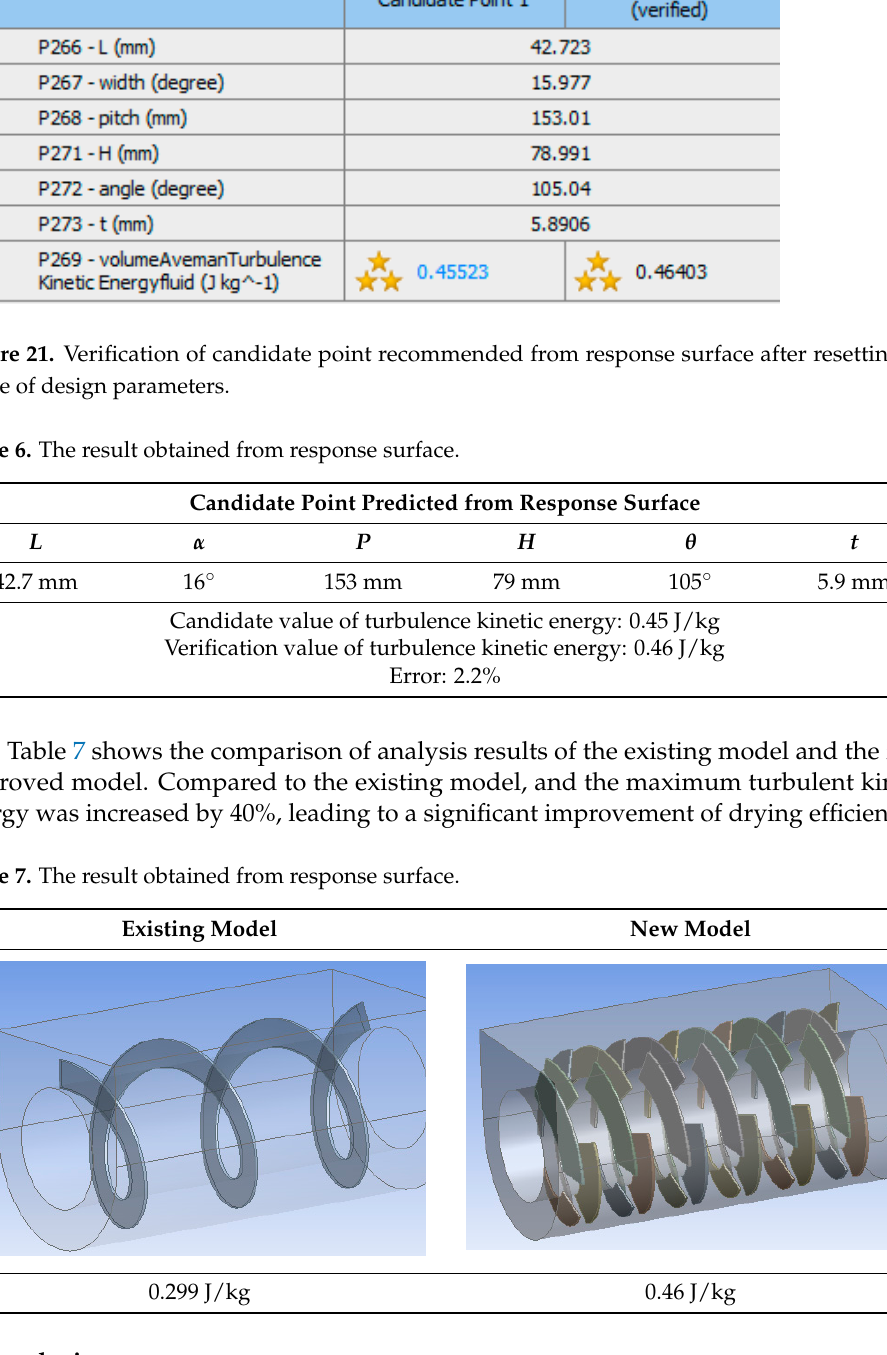
( b ) Figure 20. Verification of response surface using goodness of fit. ( a ) Before range revision of de- sign parameters. ( b ) After range revision of design parameters. In the same way as above, optimization for maximum turbulence kinetic energy was carried out, and candidate point ( L : 42.7 mm, α : 16°, P : 153 mm, H : 79 mm, 𝜃 : 105°, and t : 5.9 mm) with 0.45 J/kg was recommended, as shown Figure 21. To verify the recom- mended value through the response surface, CFD analysis was performed; its result is 0.46 J/kg, as shown in Figure 21, and the error between candidate value and the verifica- tion value of turbulence kinetic energy was 2.2%, as shown Table 6. Finally, L : 42.7 mm, 𝛼 : 16°, P : 153 mm, H : 79 mm, 𝜃 : 105 ° , and t : 5.9 mm, which has maximum turbulent flow stress, was selected as the optimal model. Table 6. The result obtained from response surface.